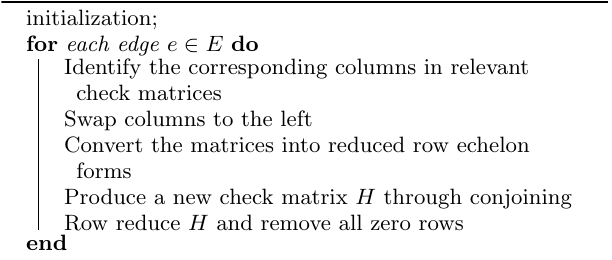
Algorithm 2. Check matrix building